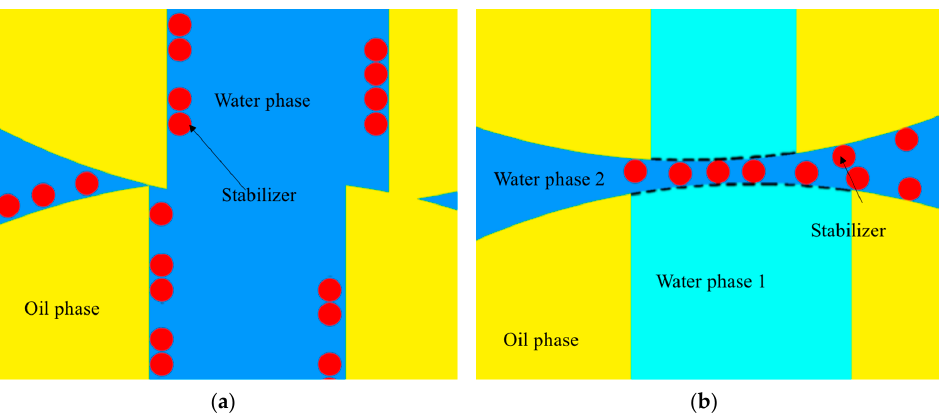
Figure 2. The schematic photographs of boundary loss ( a ) and boundary rebuild ( b ).